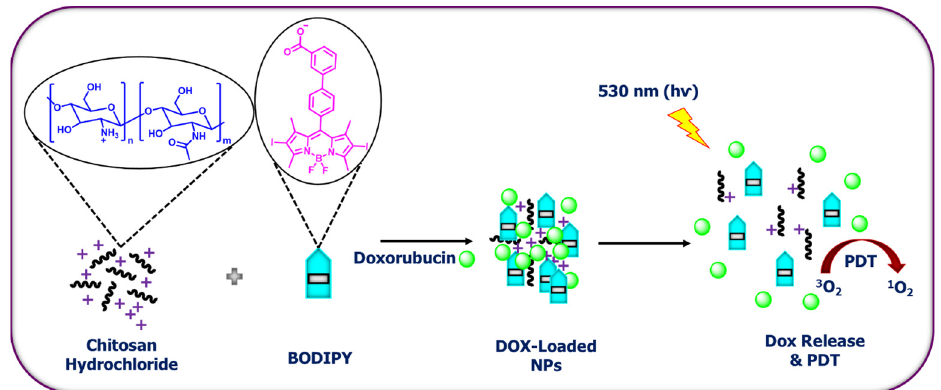
Scheme 2. The working mechanism of DOX-loaded organic